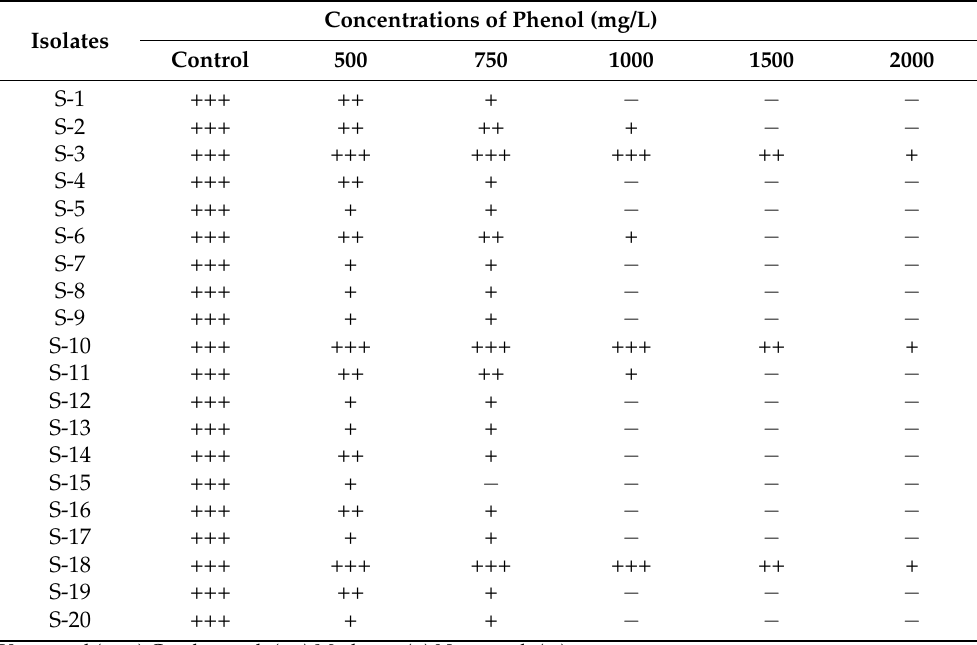
Table 3 revealed that all bacteria were G − rods, aerobic, motile, positive for oxidase- and catalase, and produced acid from glucose. Three isolates were Gram-negative, strictly